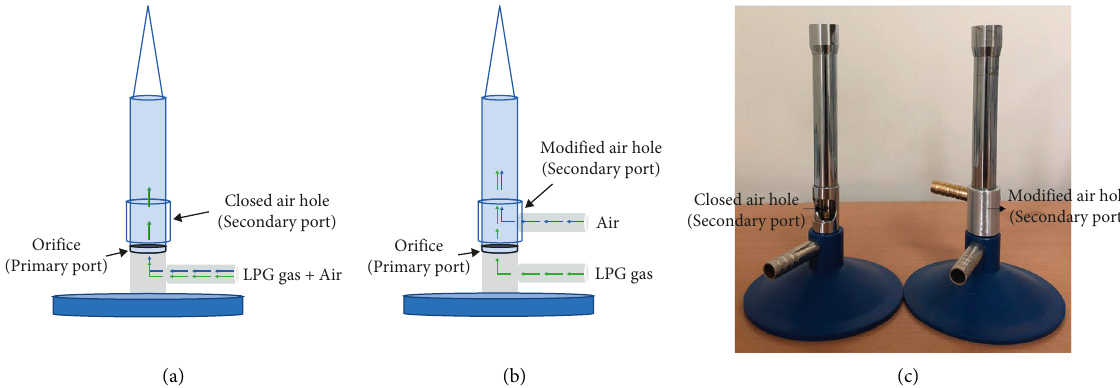
Figure 2: Illustration of Saudi LPG and air inlet connections of the Bunsen burner for the mixture of LPG and air (a) the Bunsen burner, (b) the modified Bunsen burner, and (c) photograph of the modified Bunsen burner.